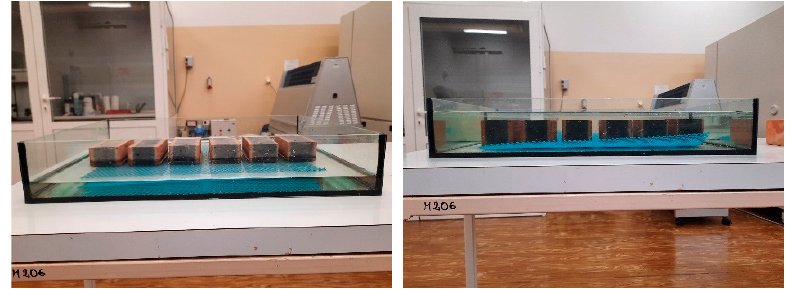
Figure 3. Absorption test.